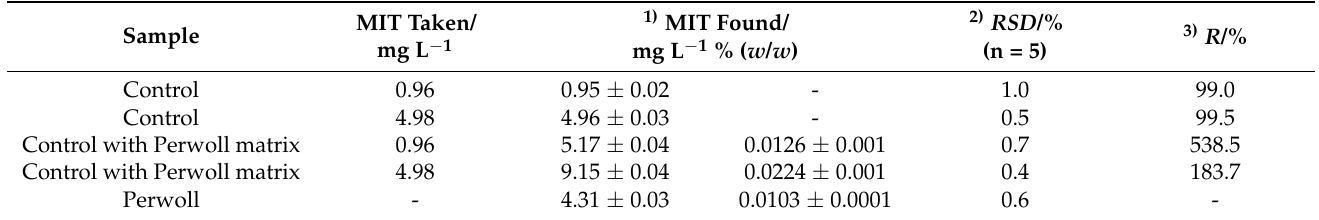
Table 2. Results of the methylisothiazolinone determination in control and in household products by